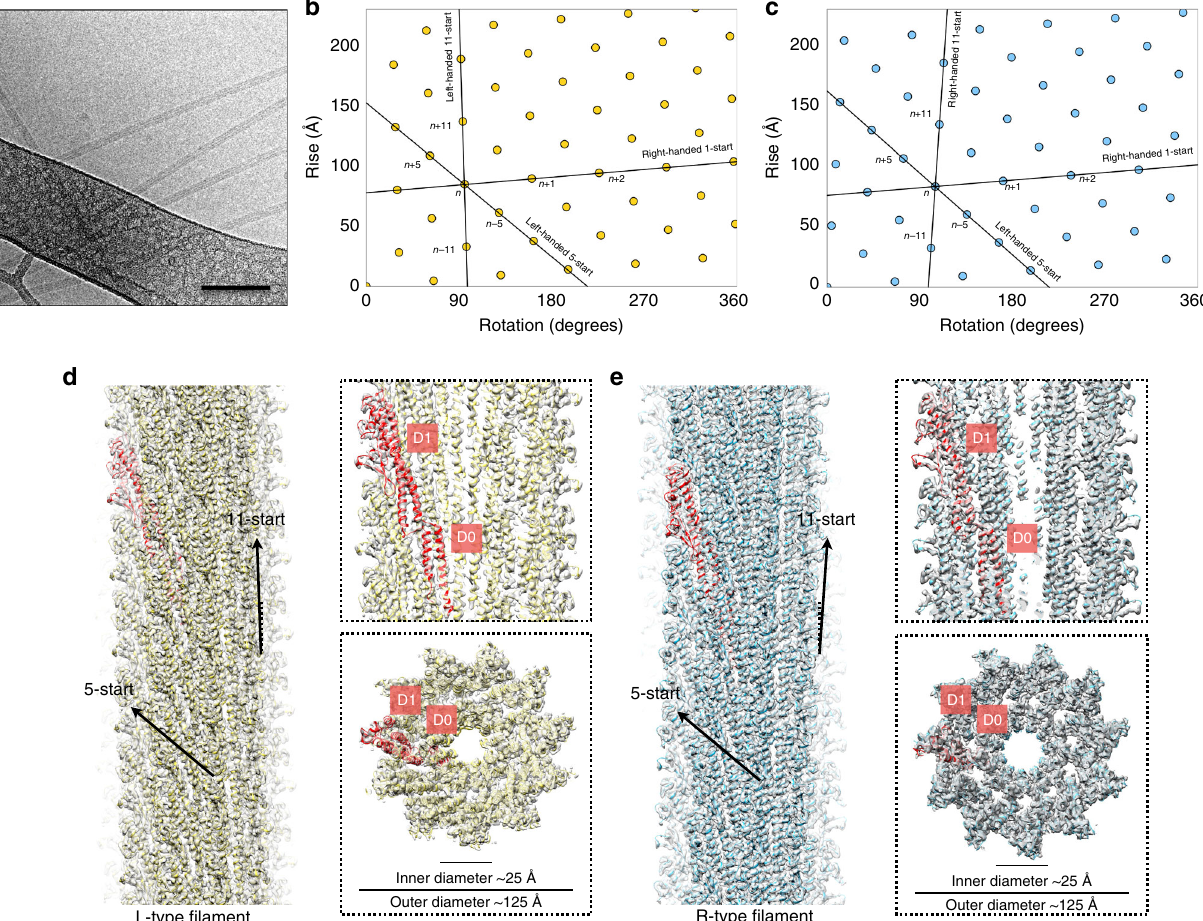
Fig. 1 Cryo-EM reconstruction and fl agellar fi lament model of B. subtilis . a Cryo-electron micrograph of B. subtilis fl agellar fi laments. The scale bar represents 100 nm. b and c The helical net of the B. subtilis fl agellar fi lament using the convention that the surface is unrolled and we are looking from the outside. The L-type fi laments are shown in b and the R-type fi laments are shown in c . d and e The surfaces of the side view, the central slice through the lumen, and the top view of the cryo-EM reconstructions (L-type straight fi lament S285P shown in d , R-type straight fi lament N226Y shown in e